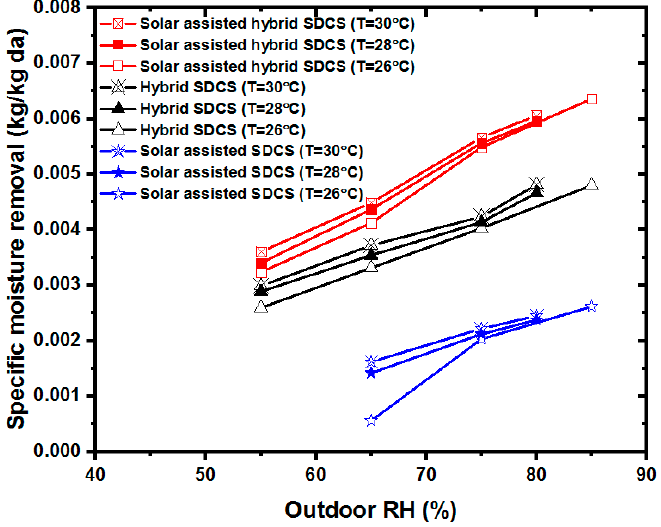
Figure 6. Effect of outdoor relative humidity ( RH ) on SMR . Figure 6. E ff ect of outdoor relative humidity ( RH ) on SMR .